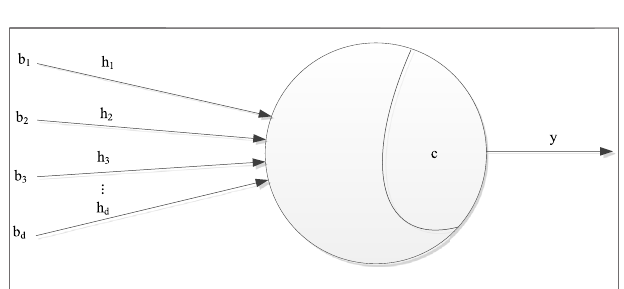
FIGURE 6 | Basic structure of